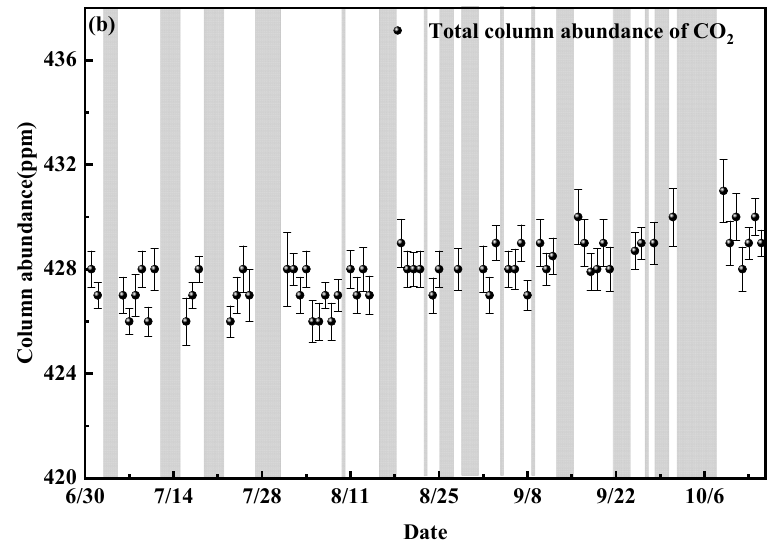
Figure 5. Total column abundance of CO 2 . ( a ) Retrieval results of CO 2 from 10:00 am to 15:00 pm on July 1, September 1 and October 15, 2022; ( b ) time series of the CO 2 retrieval results. Estimations of 95% confidence ranges are indicated.